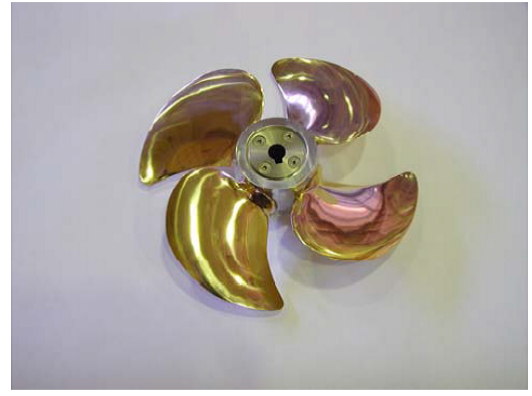
Figure 1: The RV Nawigator XXI controllable pitch